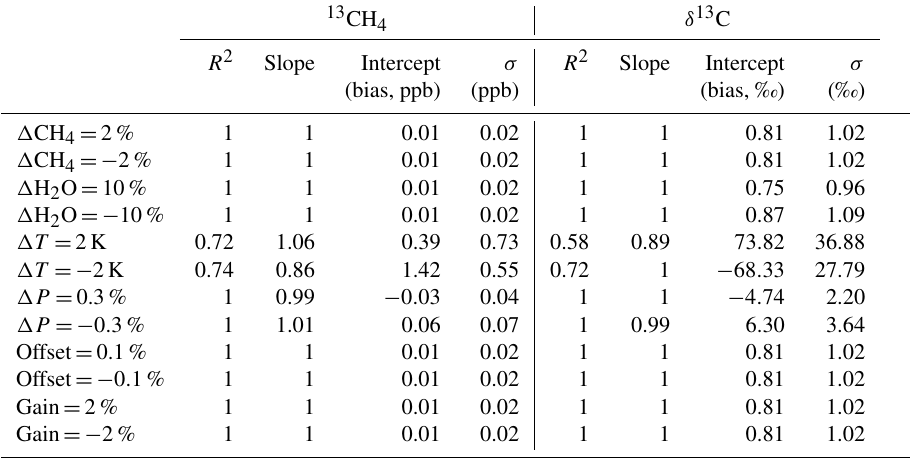
Figure 10. As Fig. 4 but focused on the Sentinel-5/5P SWIR3 band. Table 4. Effects of errors in a priori databases and instrument calibration errors on test retrievals from SWIR3 of 13 CH 4 and δ 13 C; the metrics displayed in this table are as described in Sect.